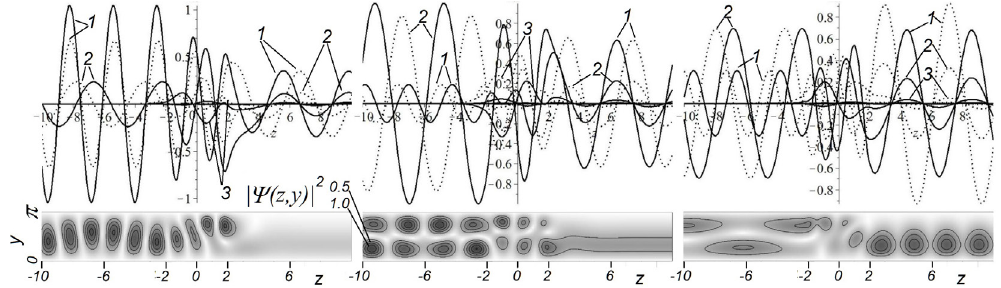
Figure 1. Real (solid lines) and imaginary (dotted lines) components Φ i (labeled by i = 1 , 2 , 3) of the solution Φ of the multichannel scattering problem for the waves, incident from the left from the first, LR(1) and the second LR(2) open channels, and the wave incident from the right RL(1), and profiles of square of absolute values 2 of the corresponding 2D wave functions Ψ ( y, z Ψ ( y, z ) | |